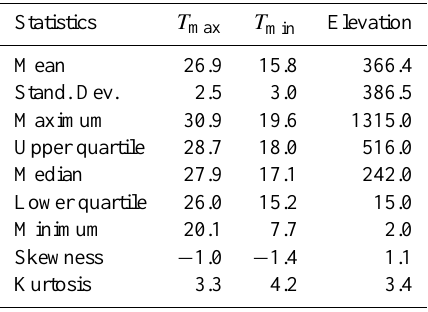
Table 1. Basic statistics of mean maximum ( T max ) and mean mini- mum temperature ( T min ) data (Celsius degrees) for June and eleva- tion data (ma.s.l.).